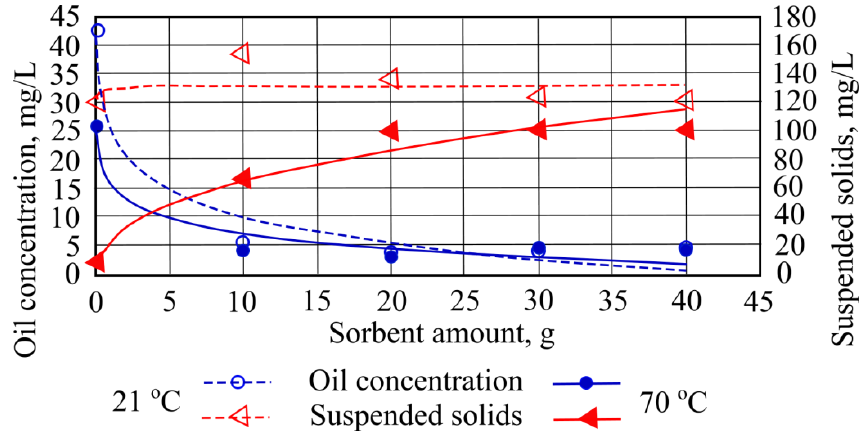
Figure 12. Oil concentration and suspended solids when different quantities of mineral granulated sorbent are added to the water.